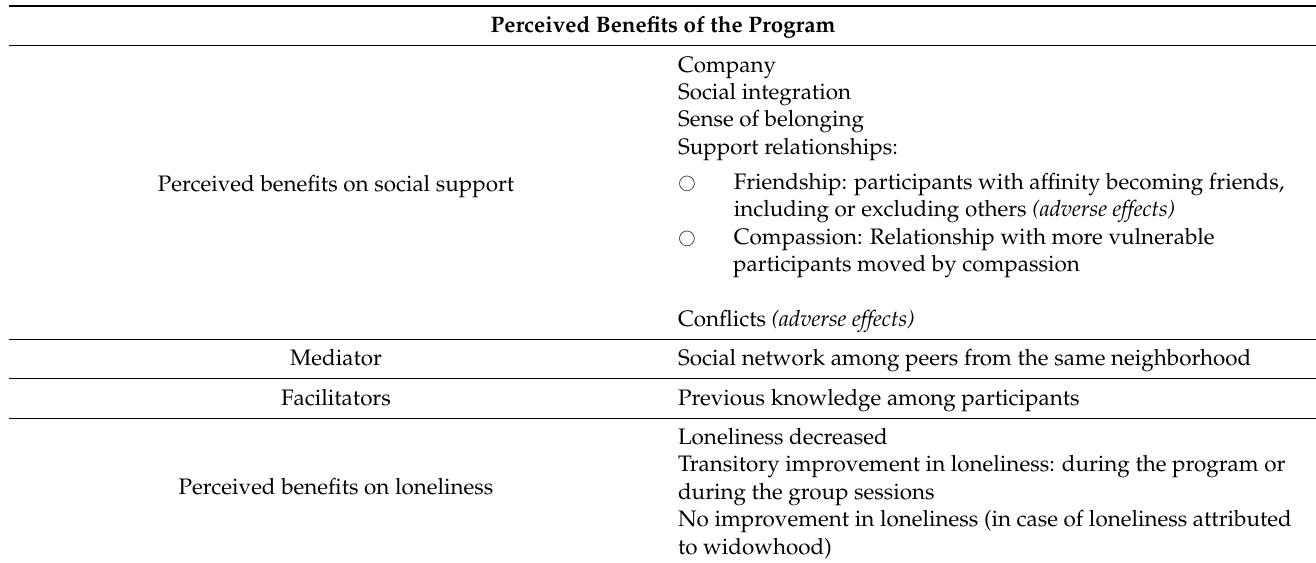
Table 3. Summary of results regarding perceived benefits of the